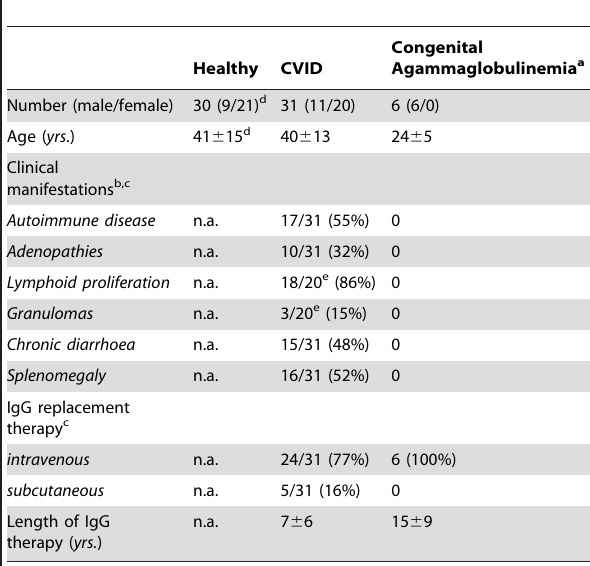
Table 1. Clinical and epidemiological data of the cohorts